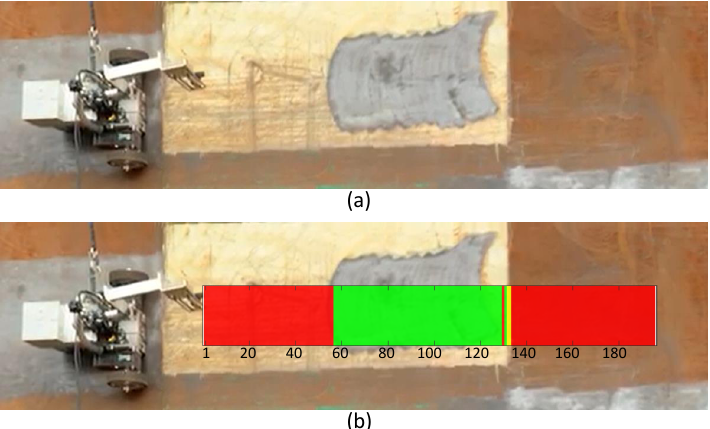
Figure 9. ( a ) Experimental setup; ( b ) The resulted benchmarking map. The benchmarking map is overlaid on the hull surface for better comparison. The areas predicted with good blasting quality by the system are given in green. The medium and bad quality areas are given in yellow and red, respectively. The corresponding frame number is annotated below the synthesized benchmarking map.